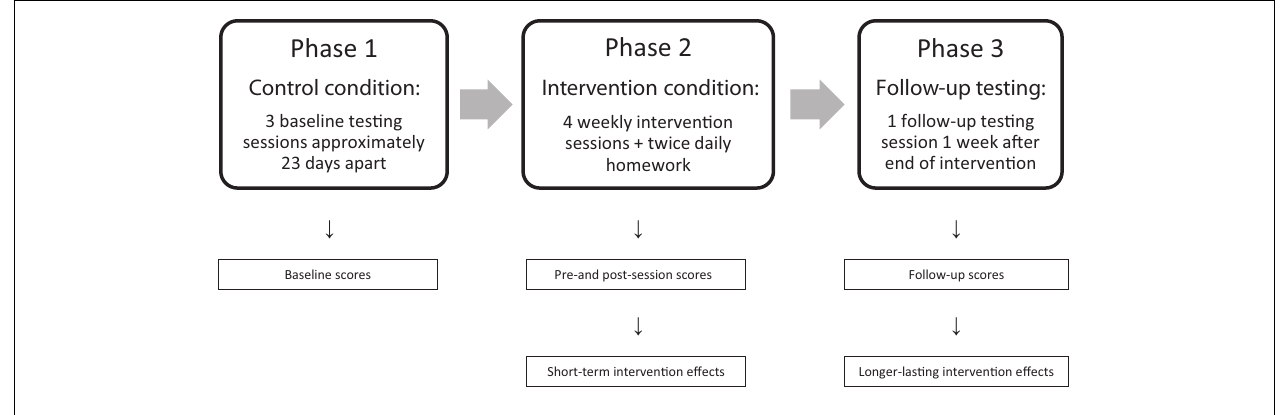
FIGURE 1 | Outline of experimental design